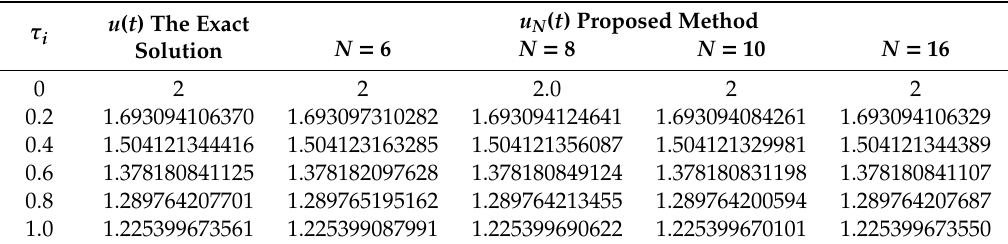
Table 2. Approximate solution of the proposed method with the analytical solution.